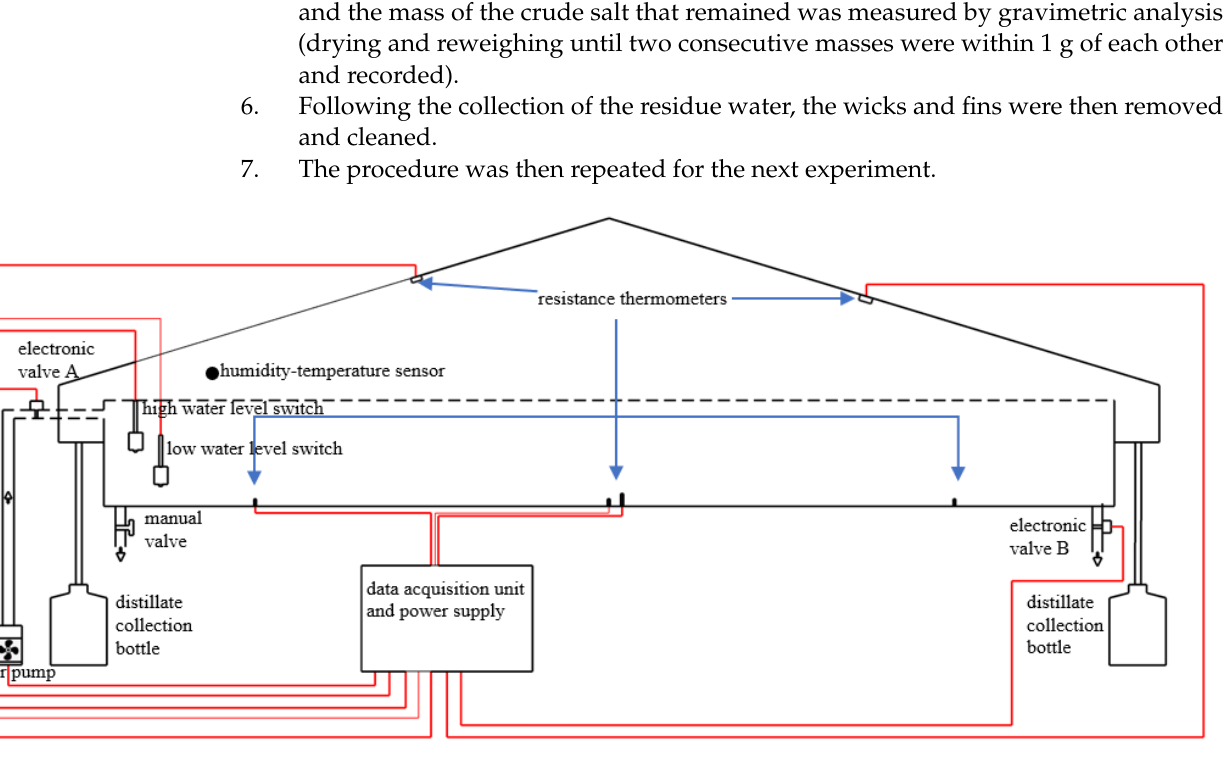
Figure 2. Schematic diagram showing the electronic components used for water level control and data capture.